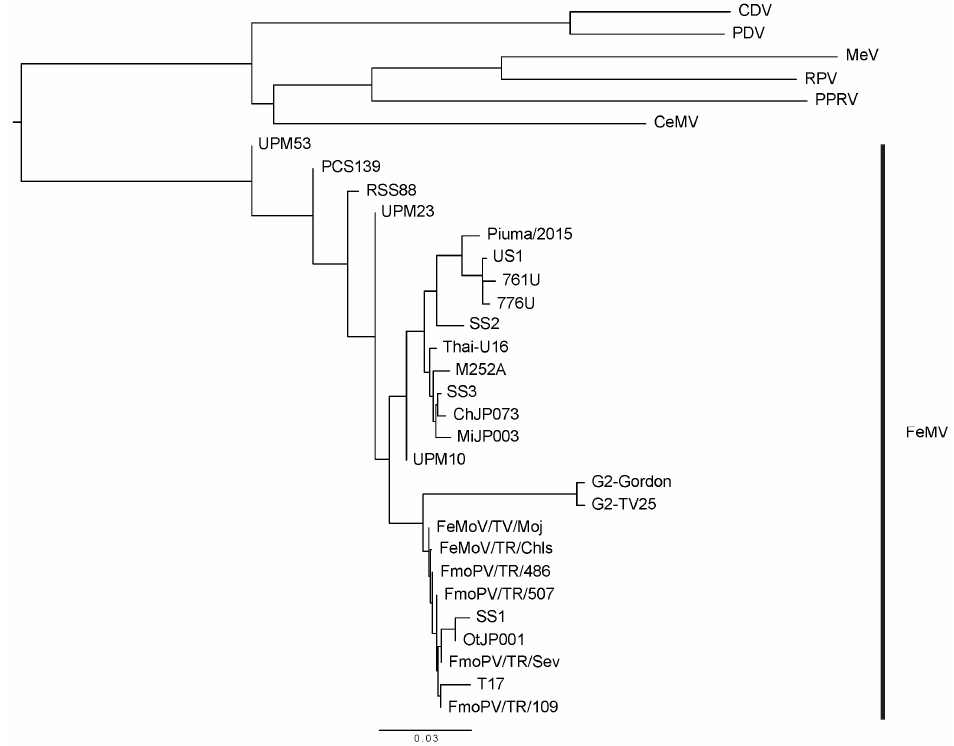
Figure 2. Diagram of the Morbillivirus family. The phylogenetic tree was built after obtaining the RNA polymerase / large protein sequences of the viruses from the NCBI Protein Database. The protein sequences were aligned by using the COBALT multiple alignment tool and the fast-minimum evolution method and visualized using FigTree. The virus names and GenBank accession numbers are: Feline morbillivirus (FeMV) strains TV17 (AVH81382.1), Thai-U16 (AVD98481.1), Piuma/2015 (AMM62640.1), US1 (AMH87247.1), 761U (YP_009512964.1), 776U (AFH55526.1), M252A